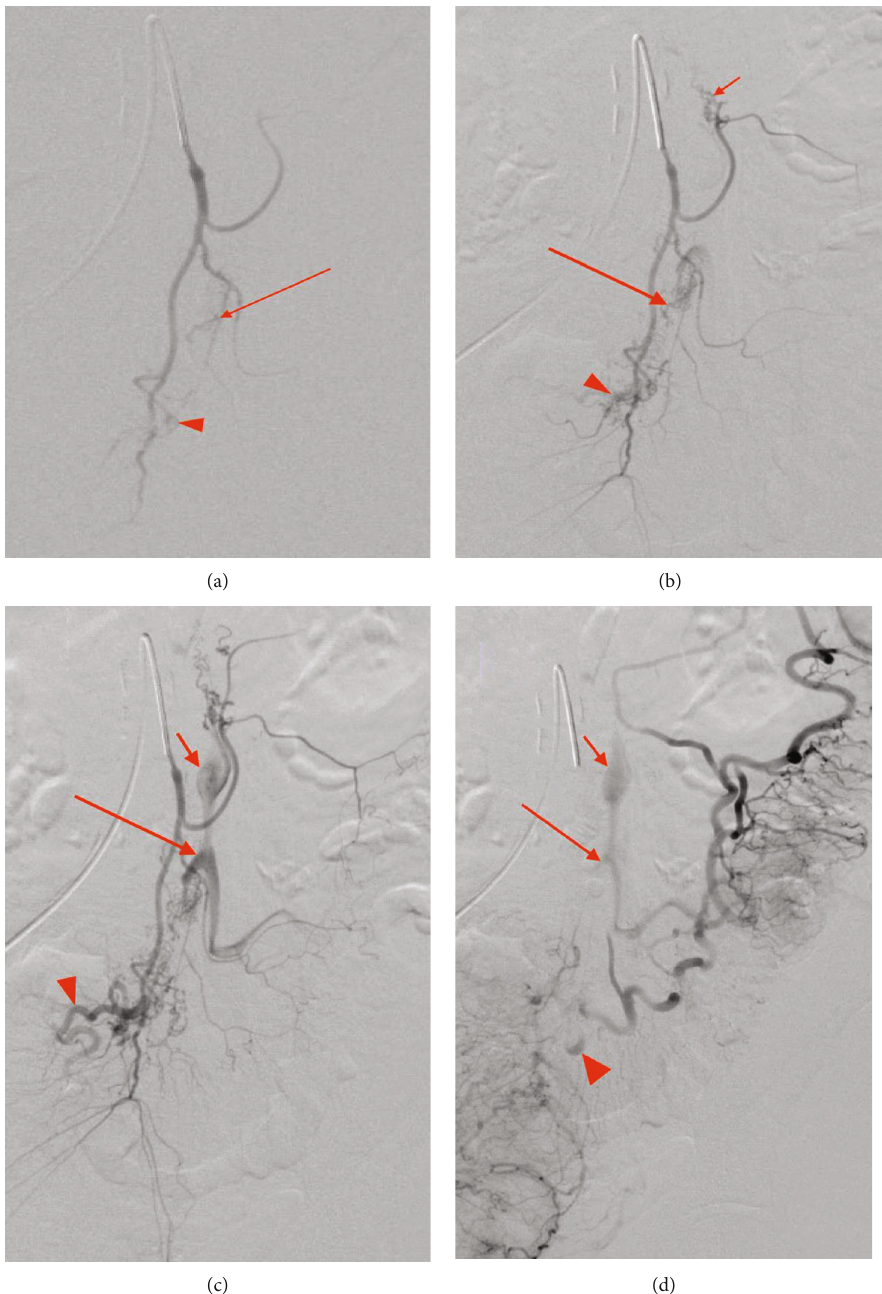
Figure 4: Mesenteric angiogram demonstrates subselection of the IMA in order of progressive fi lling which eventually displays three AVM niduses arising from the left colic artery, sigmoid artery, and superior rectal artery with respective dilated venous out fl ow tracts. Minimal opaci fi cation is seen in the presumed venous out fl ow tracts (a) of the AVM niduses at the sigmoid (red arrow) and superior rectal artery (arrowhead). Progressive opaci fi cation (b) is noted in the sigmoid (long arrow) and superior rectal niduses (arrowhead); opaci fi cation of the left colic nidus is demonstrated (short arrow). Ectatic venous out fl ow tracts of the left colic (c) (short arrow), sigmoid (long arrow), and superior rectal (arrowhead) AVM niduses are seen. Washout of the venous out fl ow tracts of the three AVM niduses (d) is demonstrated with similar labeling as